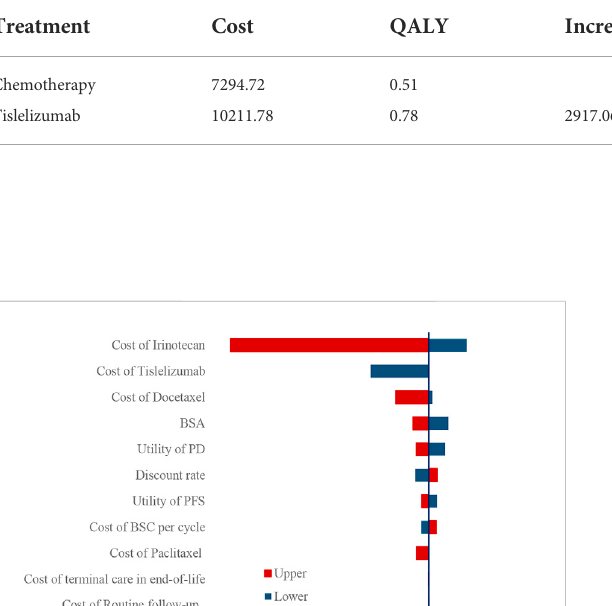
TABLE 3 Base case results from the cost-effectiveness analysis.